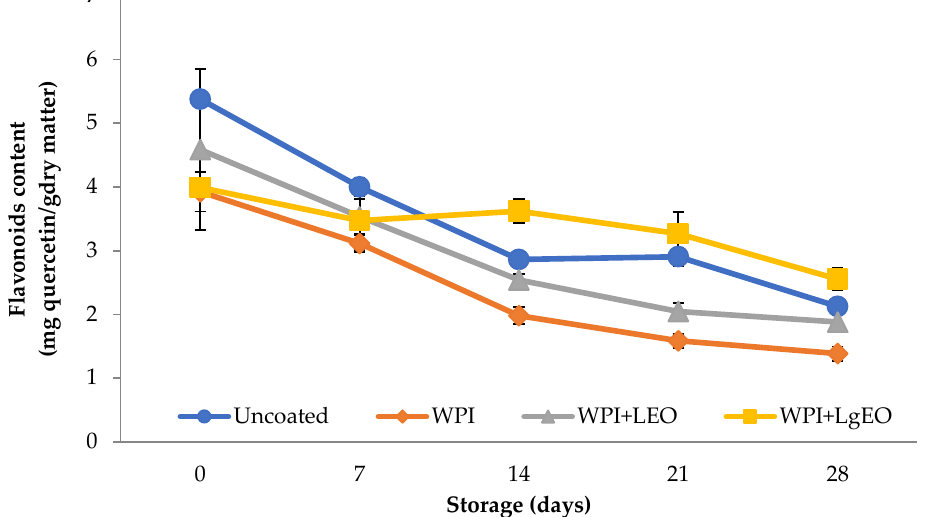
Figure 5. Flavonoids content of fresh-cut pears coated with whey protein isolate coatings (WPI) incorporated with lemon (WPI + LEO) and lemongrass (WPI + LgEO) essential oils or uncoated samples during 28 days of storage at 4 °C.